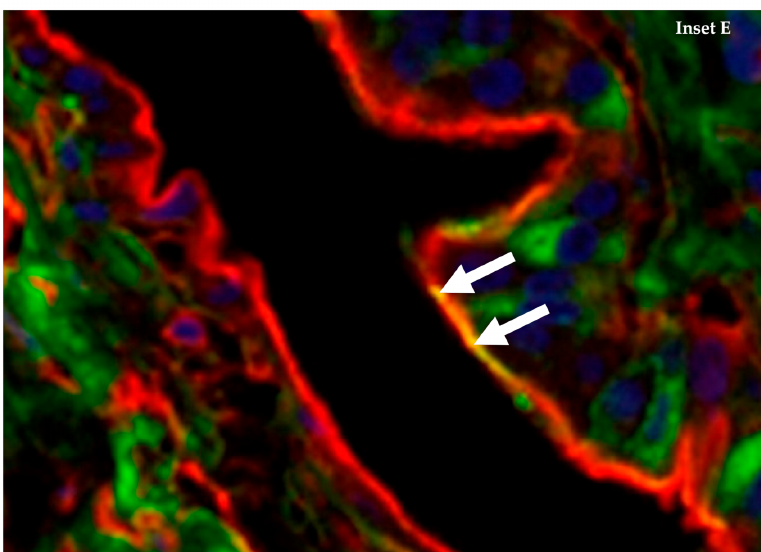
Figure 2. Close up view of Inset E from Figure 1 with arrows pointing to cells from the epithelial lining of the bronchi colour stained for both α -2,3 SA and α -2,6 SA receptors (yellow indicates a mixture of red and green staining). Tissue sections stained with biotinylated MAAII (red-specific for α -2,3-Gal SA) and FITC labelled SNA (green-specific for α -2,6-Gal SA) lectins, and nuclear staining with DAPI (blue). Adapted with permission from ref. [60]. Copyright 2017 Elsevier.